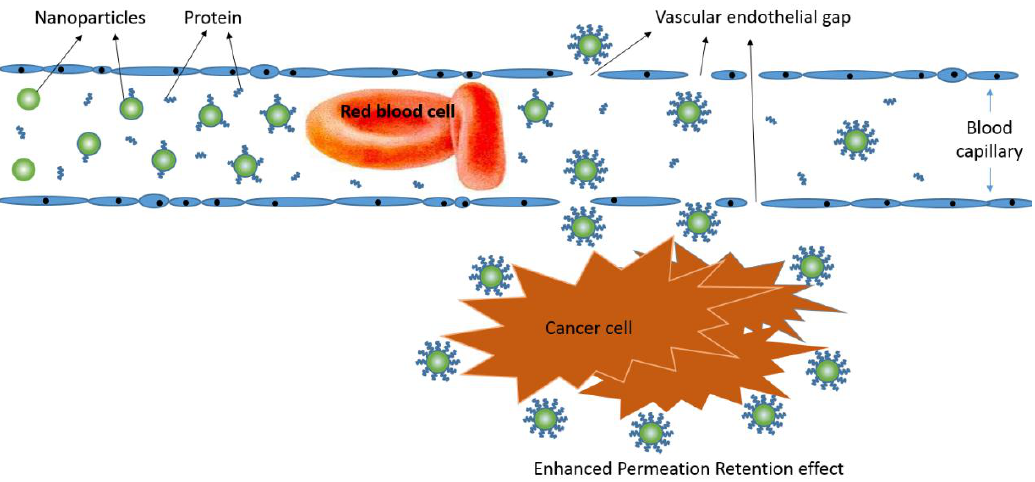
Figure 10. Illustration of movement of NPs from blood to targeted tissue.